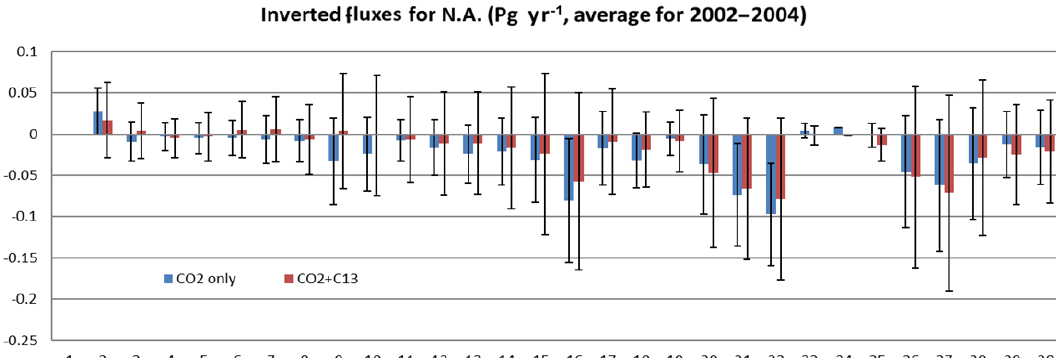
Figure 11. Comparison between inversion results with and without 13 CO 2 constraint for 30 regions in North